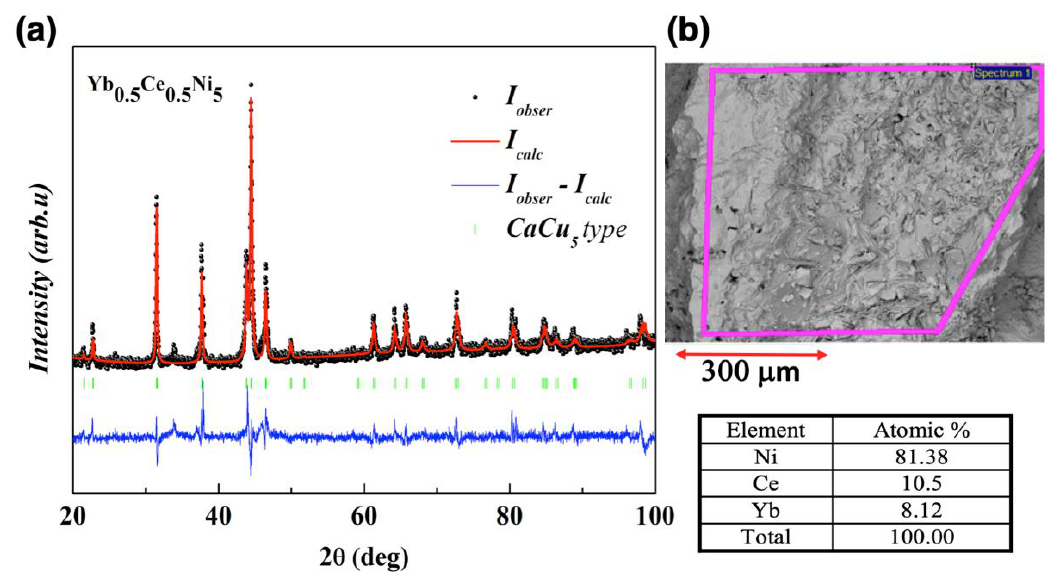
Figure 1. ( a ) Rietveld refinement and collected experimental data of the room-temperature X-ray powder diffraction patterns of Yb 0.5 Ce 0.5 Ni 5 compound. ( b ) The Yb 0.5 Ce 0.5 Ni 5 SEM micrograph of the studied sample with the table of obtained EDX analysis data of atomic % for required elements. Table 1. The atomic coordinates and occupancies of Yb 0.5 Ce 0.5 Ni 5 .